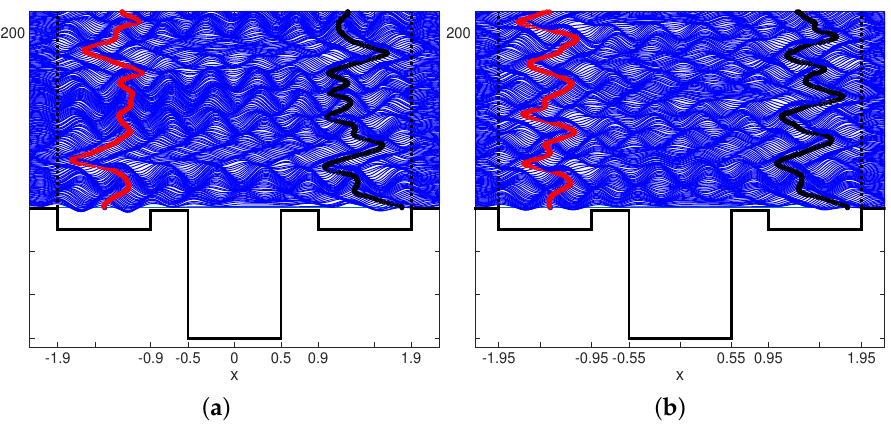
Figure 14. ( a ) On the left, the same simulation as in Figure 13. The vertical axis indicates that the simulation goes a bit beyond 200 T F . ( b ) On the right graph, a simulation with a slightly wider mid-cavity, of width equal to 1.1